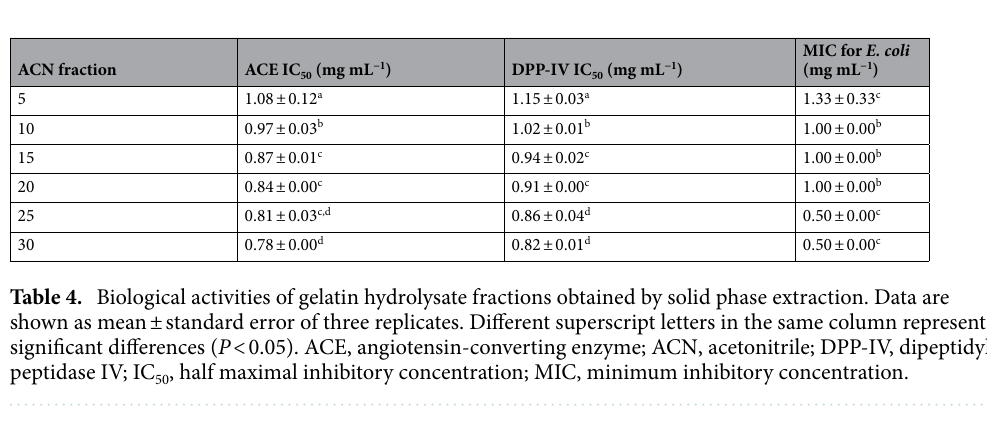
Table 3. Biological activities of gelatin hydrolysate fractions obtained by anion exchange separation. Data are shown as mean ± standard error of three replicates. Different superscript letters in the same column represent significant differences (P < 0.05). ACE, angiotensin-converting enzyme; DPP-IV, dipeptidyl peptidase IV; IC 50 , half maximal inhibitory concentration; MIC, minimum inhibitory concentration; N/A, means not applicable.